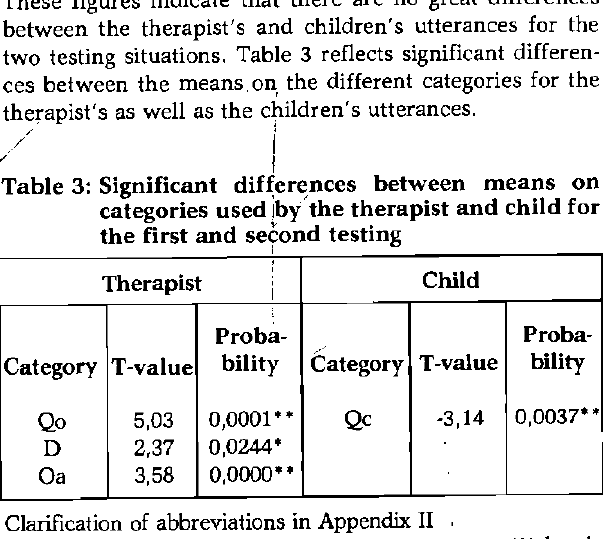
Clarification of abbreviations in Appendix II . ** = Significant on 1% level, * = Significant on 5% level.